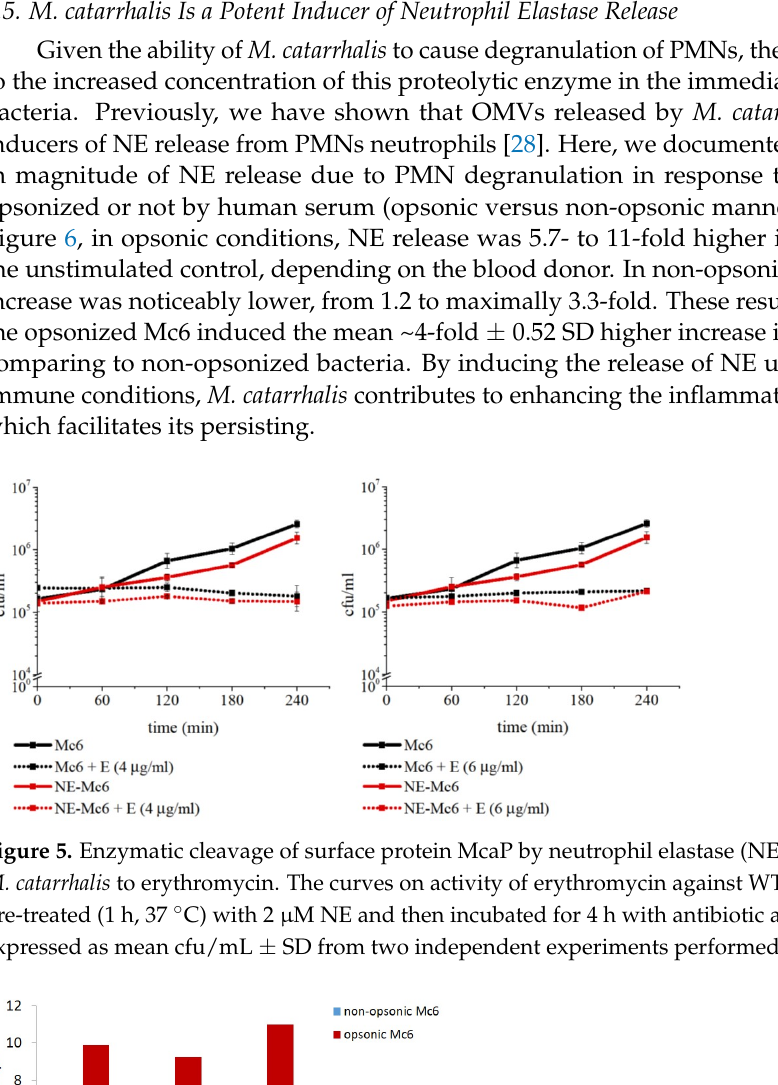
Figure 6. M. catarrhalis Mc6 is effective stimulator of human PMNs degranulation and elastase release. Human neutrophil samples at ~1 × 10 7 cell/mL from four volunteers S1–S4 were primed with